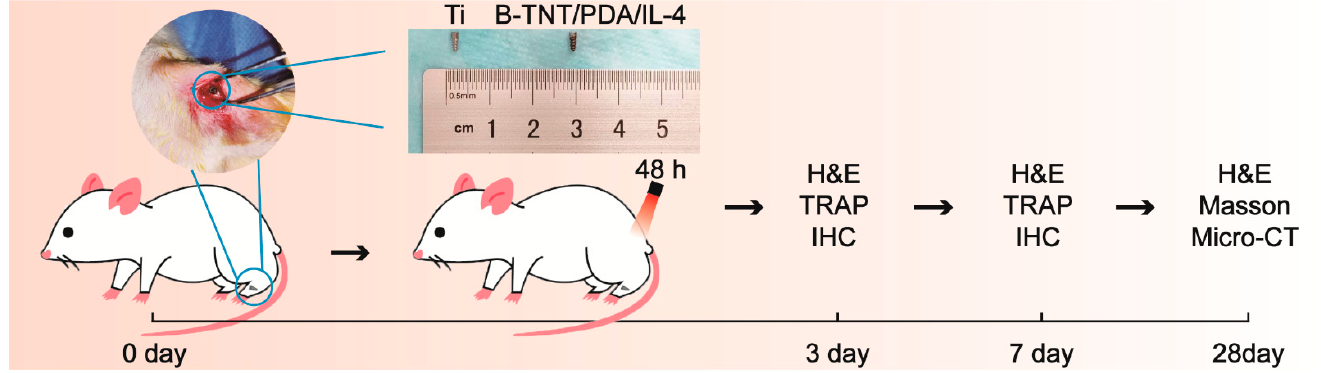
Figure 6. Schematic diagram of experimental design and implants used in the experiment.